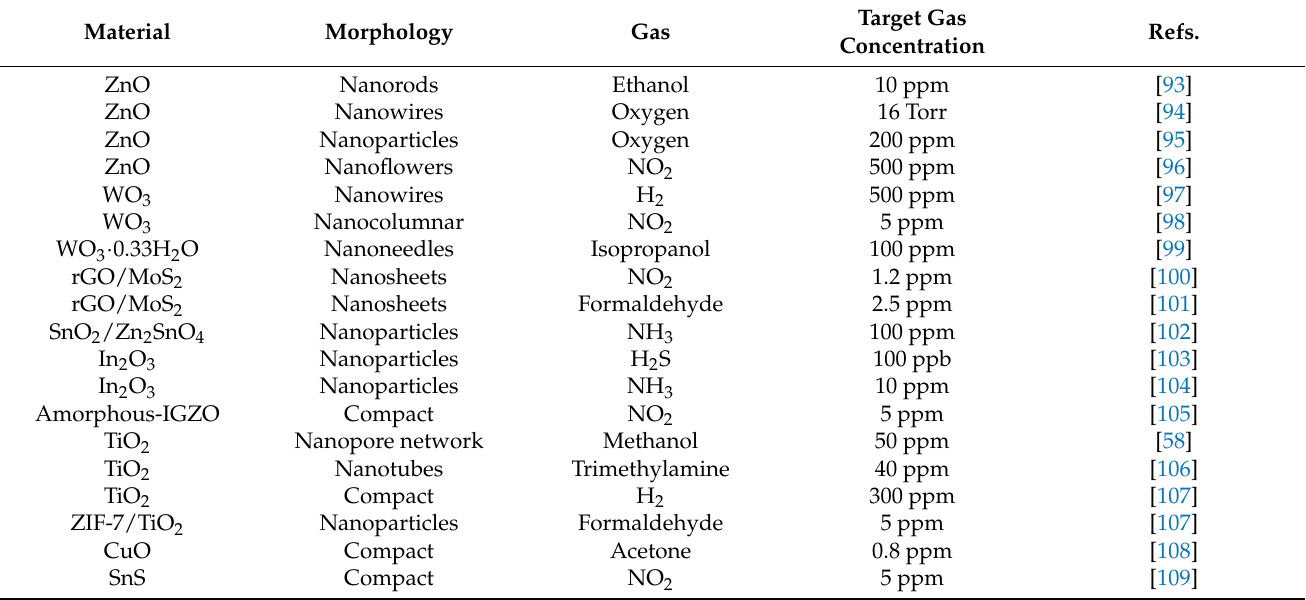
Table 3. Gas-sensing properties and the morphology of nanoceramic flexible gas sensors. Target Gas Gas Concentration